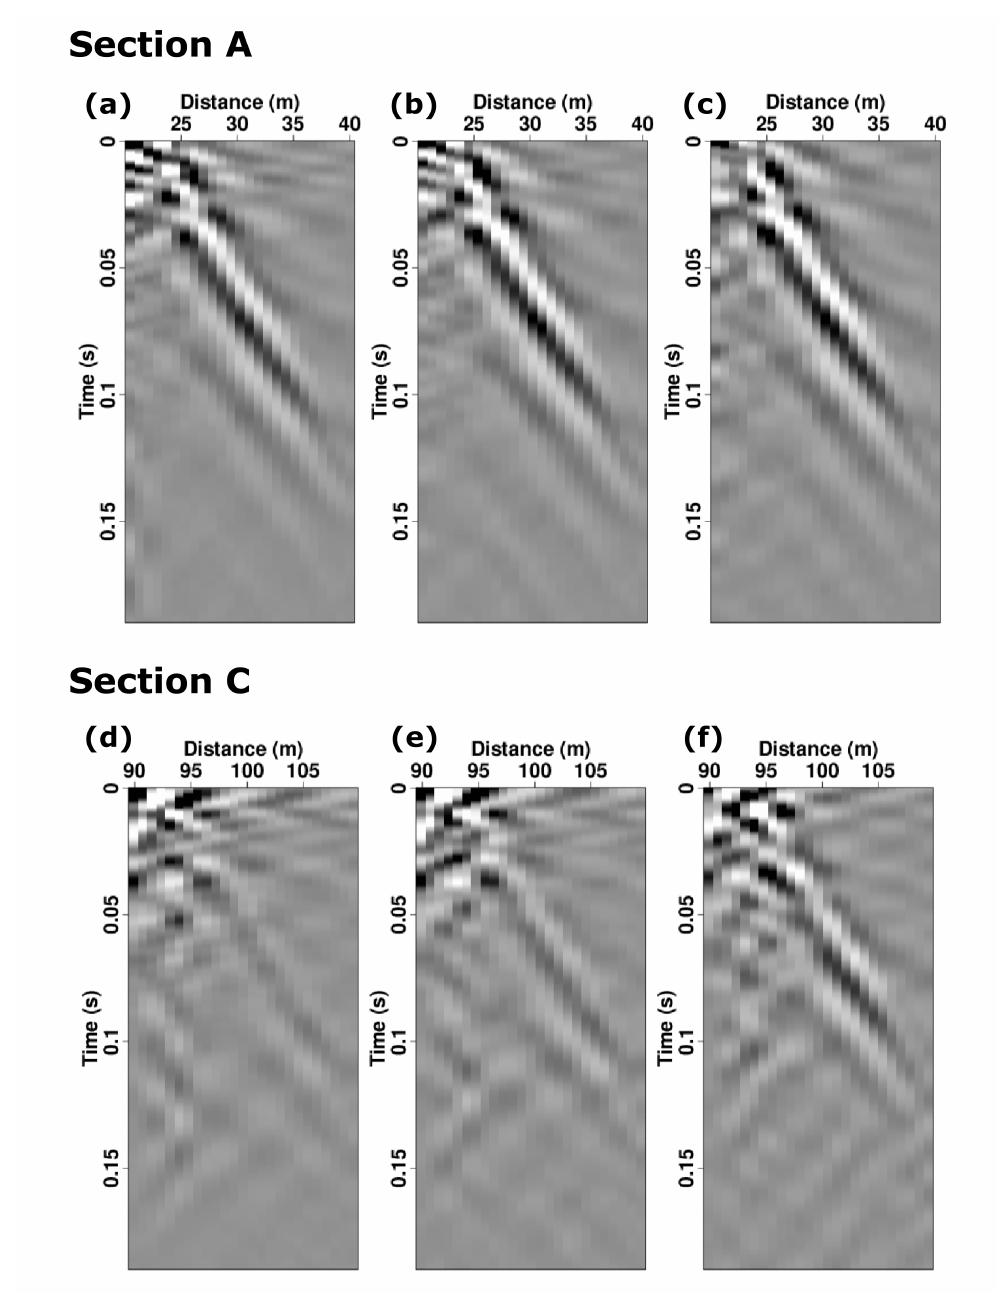
Figure 7. Repeat deformation-rate DAS shot gathers recorded on the frozen, backfilled trenched fiber Section A (upper panels) and the surface-deployed fiber Section C (lower panels). ( a , d ) 3:00 p.m. ( b , e ) 5:30 p.m. ( c , f ) 9:00